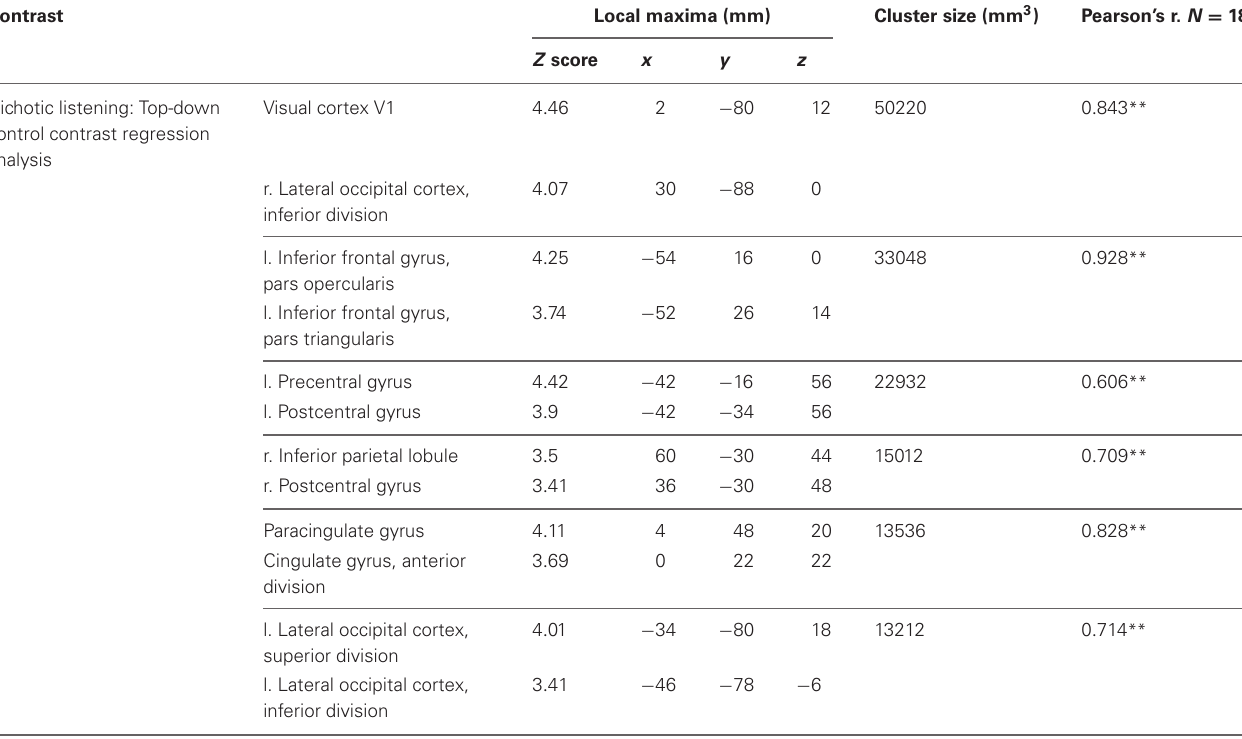
Table 2 | Summary of imaging results for regression analysis under the top-down control contrast. Contrast